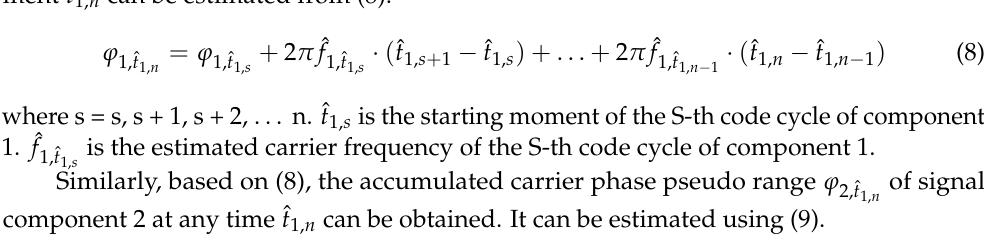
Figure 7. Example of the time distribution of discrete signals between two signal components. The cumulative carrier phase pseudo-range ϕ 1,ˆ of signal component 1 at any mo- t 1, n ment ˆ t 1, n can be estimated from